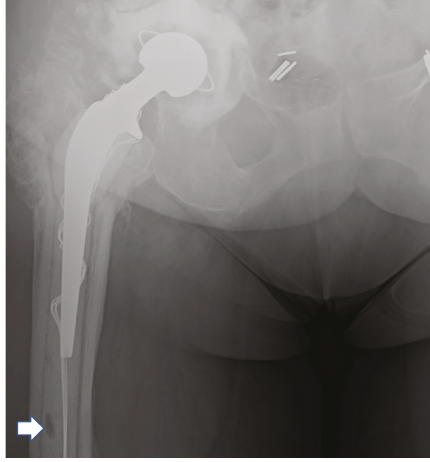
Figure 9: XR right hip. Radiolucencies around the femoral component (arrowhead).